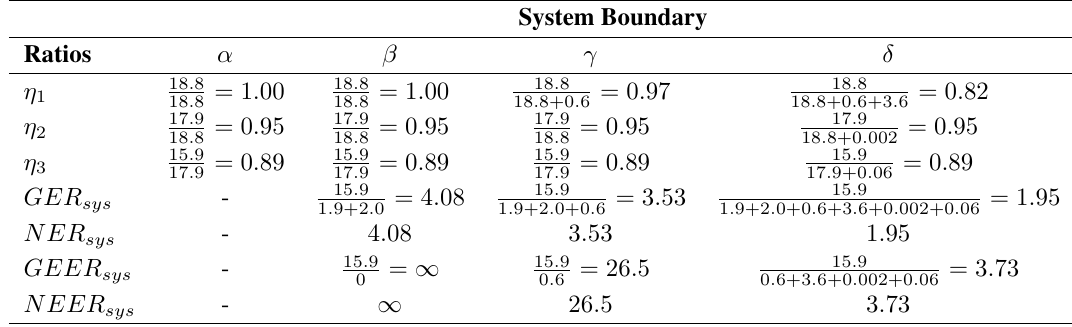
Table 4. Efficiencies and energy return ratios for the example PV production process. As discussed in the text, collection losses are omitted from the analysis.